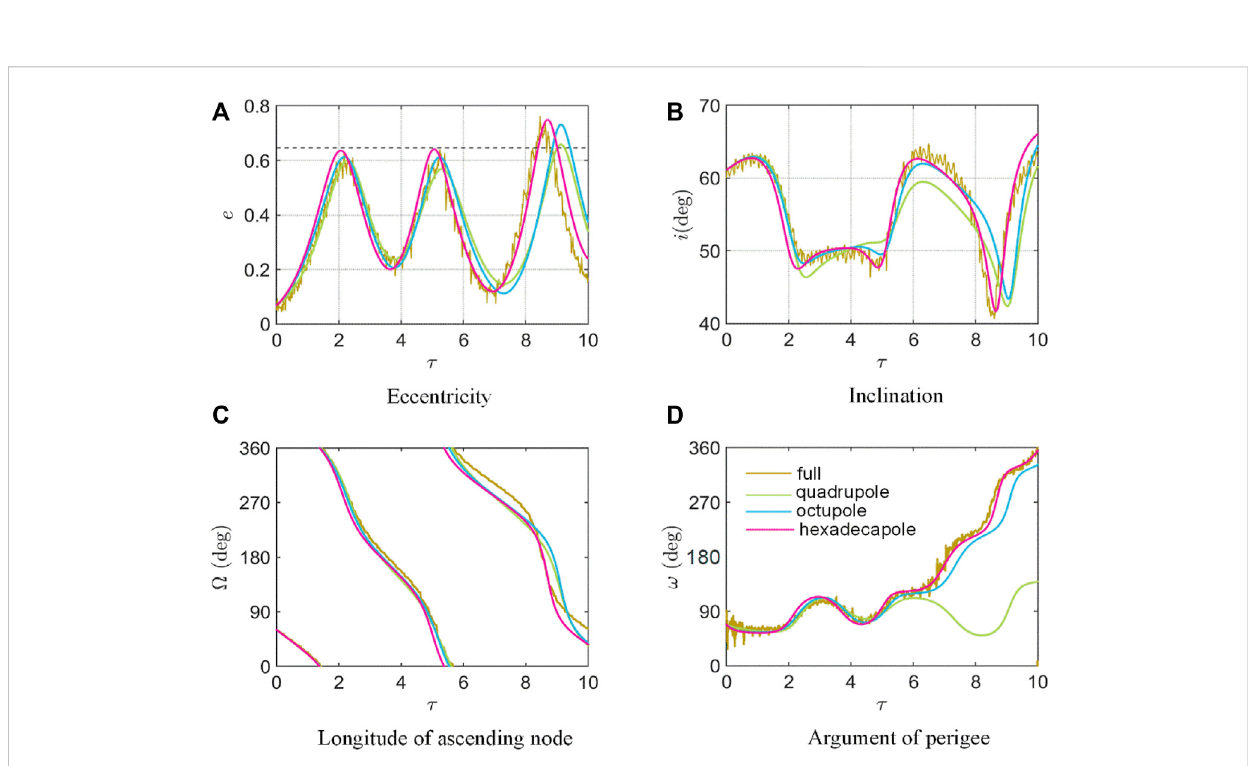
FIGURE 5 Long-term orbital evolution for a (cid:2) 7 . 8km over 10 scaled time with the other conditions set the same as Figure 4. The panels (A – D) exhibit the temporal evolution of the eccentricity, inclination, longitude of ascending node, and argument of perigee, respectively.